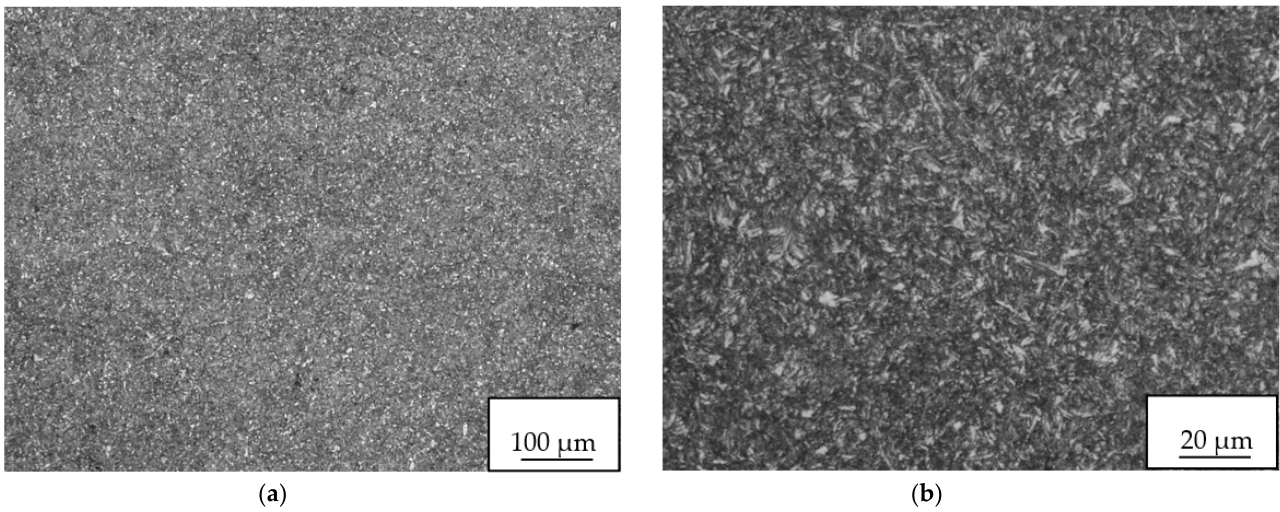
Figure 13. Fine grained, tempered martensite microstructure at edge of steel plate (sample 2). ( a ) Microstructure of steel formed by tempered martensite; ( b ) Detail of the tempered martensitic microstructure of steel.